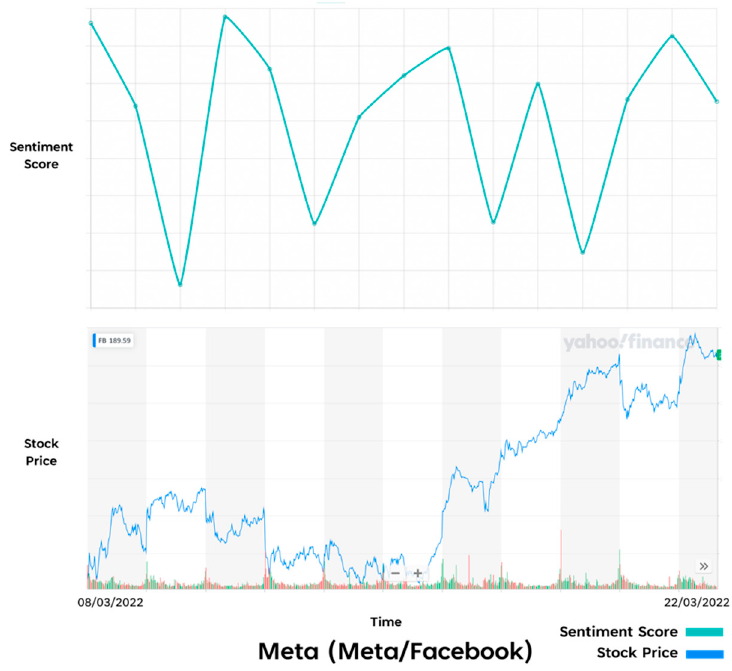
Figure 18. Comparison of Prototype results and Real-Life results—GOOG.